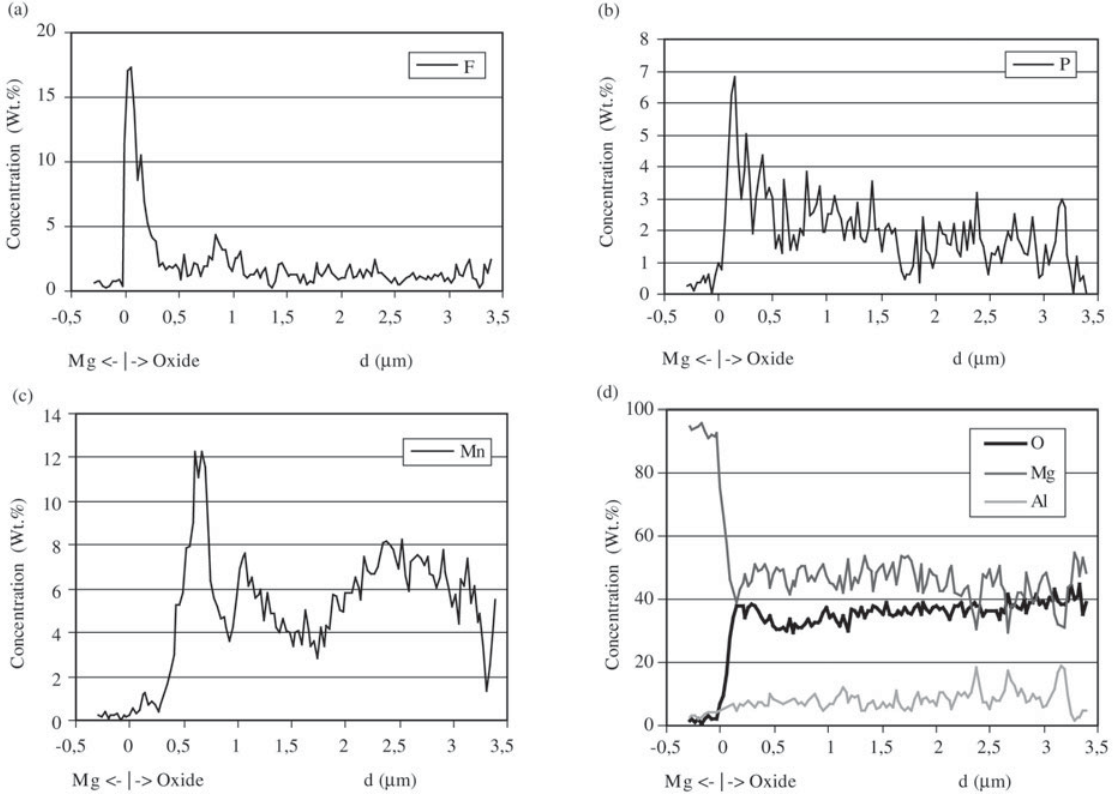
Figure 4 . EDS-Line-scans over anodic oxide film shown in Fig. 3. Concentration (wt.%) vs. distance d from the metal/oxide interface: a: Fluorine; b: Phosphorus; c: Manganese, d: Magnesium, aluminum and